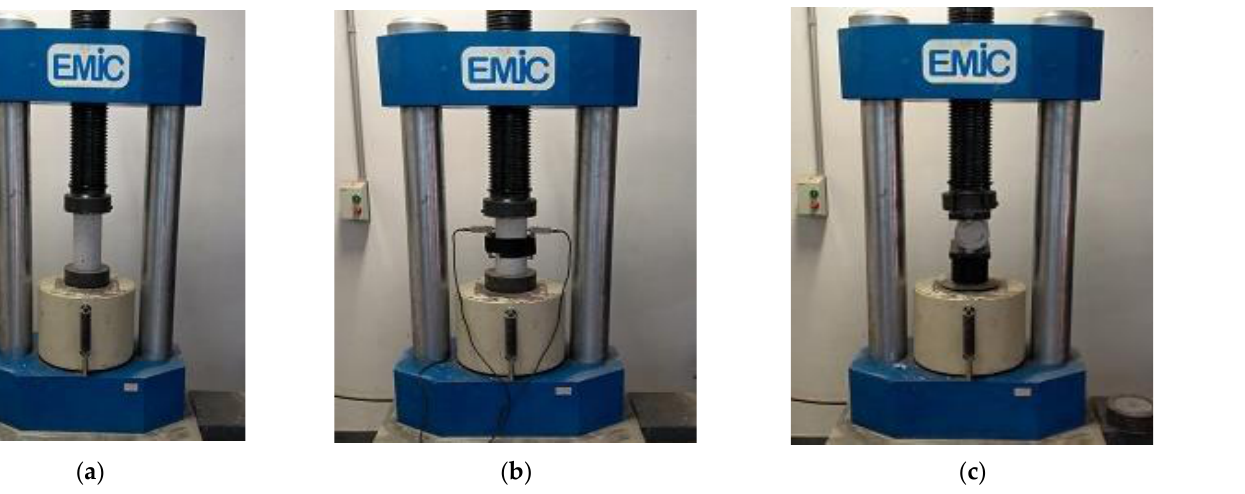
Figure 4. Test scheme: ( a ) compressive strength, ( b ) modulus of elasticity in compression, and ( c ) tensile strength.